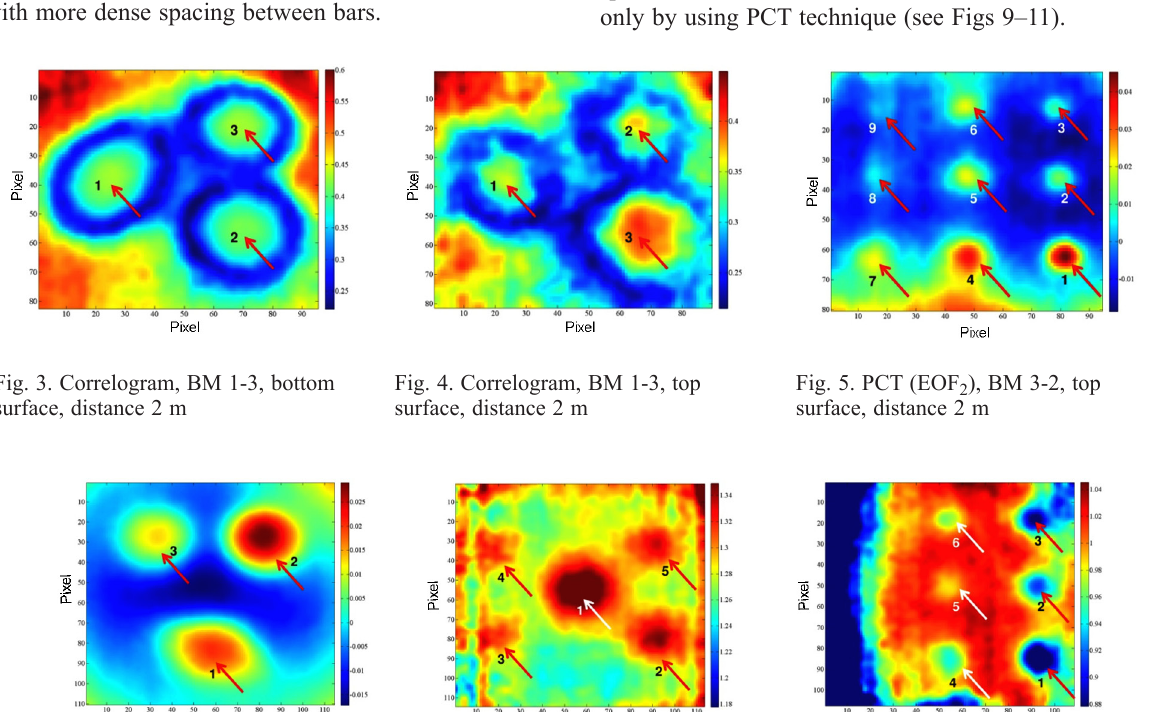
Fig. 7. Phasegram, BM 3-1, bottom surface, distance 1.5 m ( f = 1.377×10 –3 Hz)